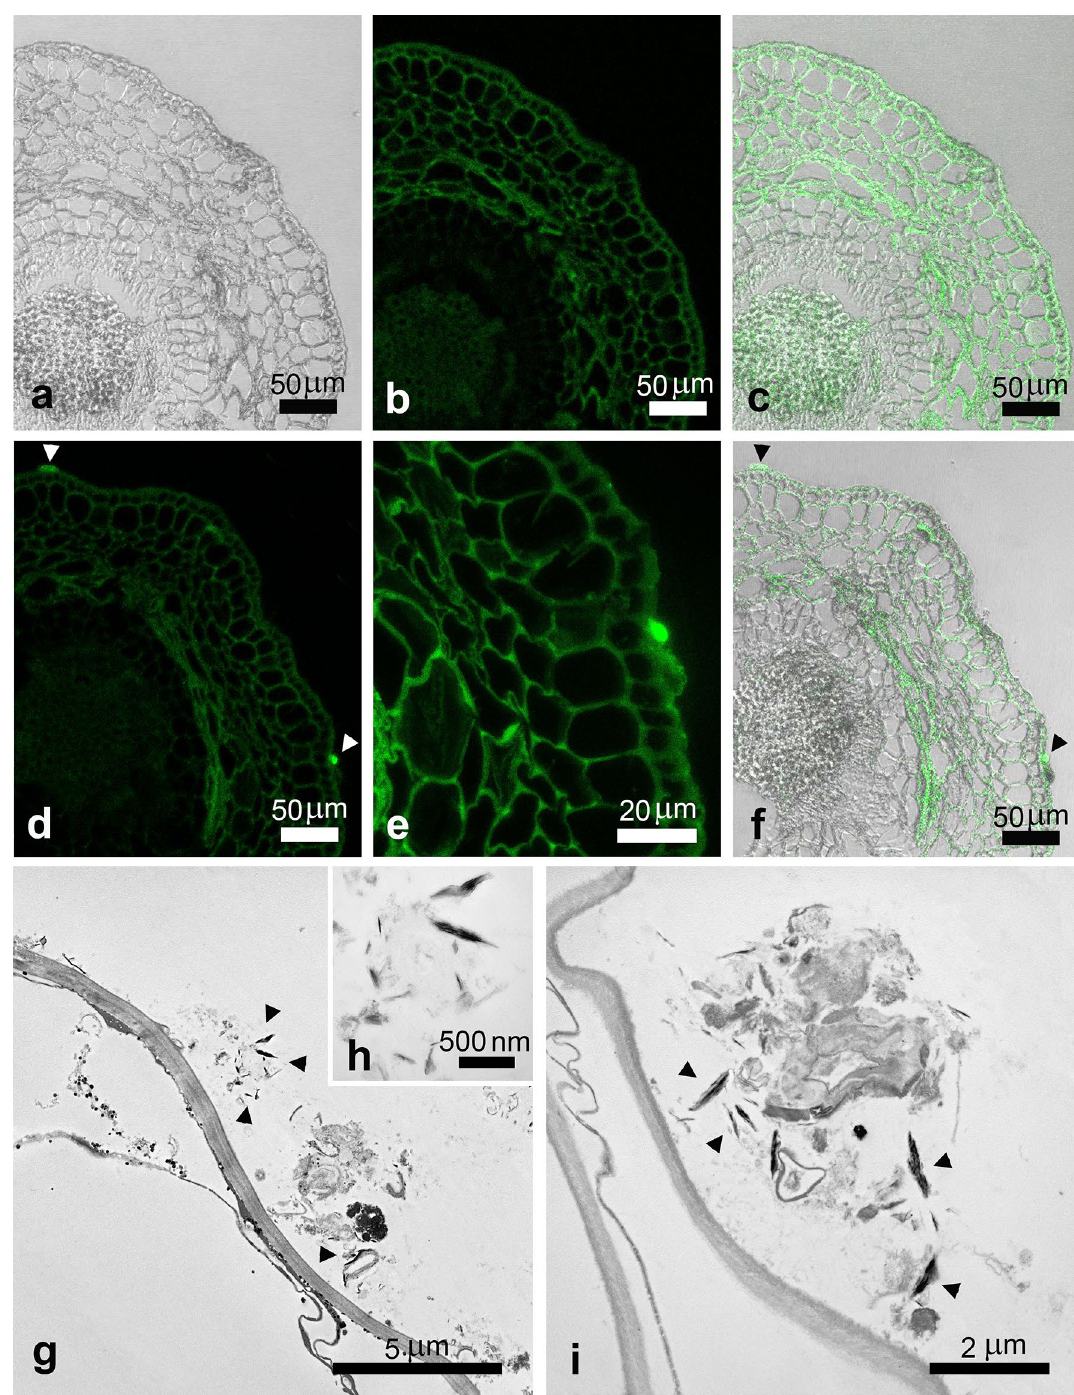
Figure 4. Differential Interference Contrast (DIC), confocal and merged-channels micrographs of control olive root in cross sections ( a–c ), where autofluorescence of cellulose was evidenced. In samples treated with 1% w/v CNCs some fluorescent spots were detected on the outer surface of the root (( d–f ), arrowheads). Ultrastructural analysis by TEM evidenced the presence of needle-like electron dense structures attributable to CNCs, often associated with externally present amorphous material (( g–I ),